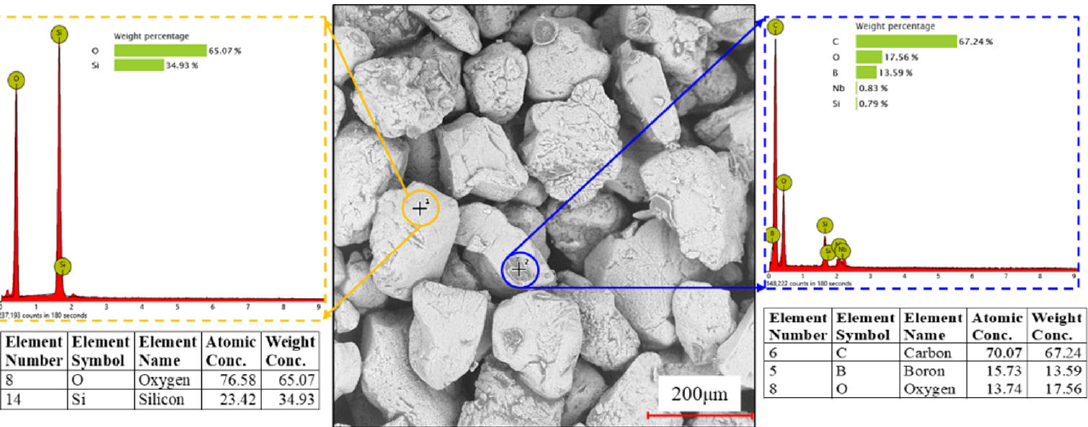
Figure 13. SEM–EDS test of sand grain and binder distribution (Type Ⅰ sand mixture is used as an example).